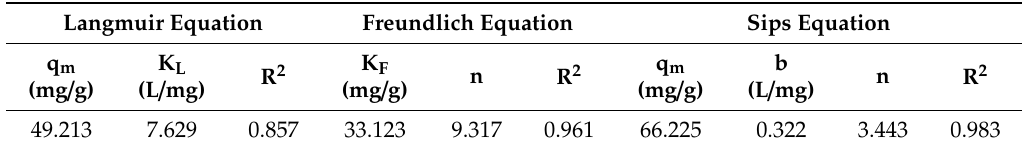
Table 3. The parameters for Langmuir, Freundlich, and Sips isotherm models of PRO adsorption onto GO / Fe 3 O 4